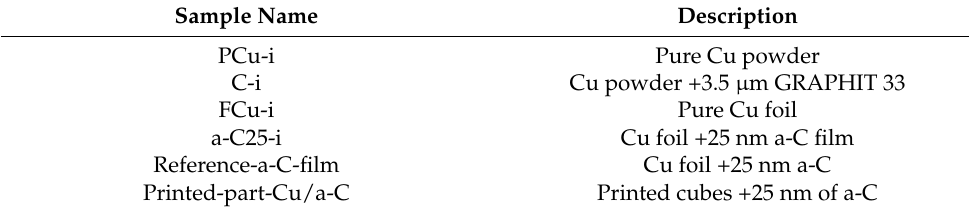
Table 2. Description of the samples used in this